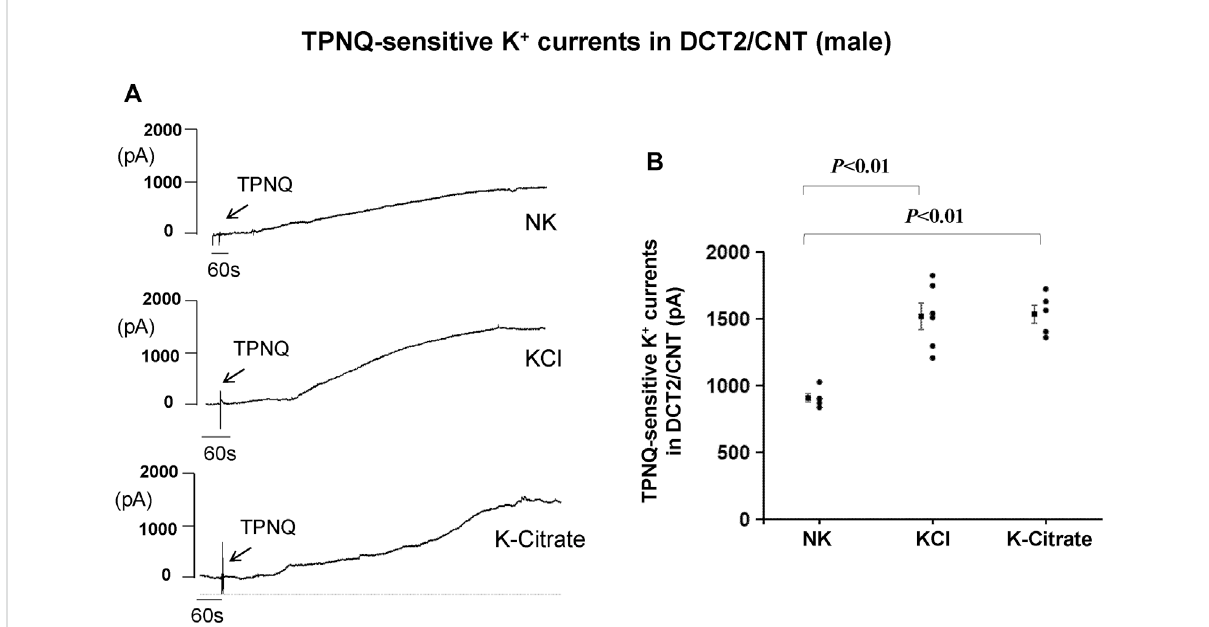
FIGURE 4 HK intake stimulates ROMK in the DCT2/CNT of male mice regardless Cl − content. (A) A set of whole-cell recordings shows TPNQ (400 nM)- sensitive (ROMK-mediated) K + currents in the DCT2/CNT of the male mice on NK, 5% K-Cl, and 5% K-citrate diet for 7 days, respectively. The K + currents were measured with gap-free protocol at − 40 mV using symmetrical 140 mM KCl solution in the bath and pipette. (B) A scatter graph summarizesthevaluesmeasuredat – 40 mVintheDCT2/CNTofmalemiceondifferentK + diets.ThemeanvalueandSEMareshownontheleft of each column.